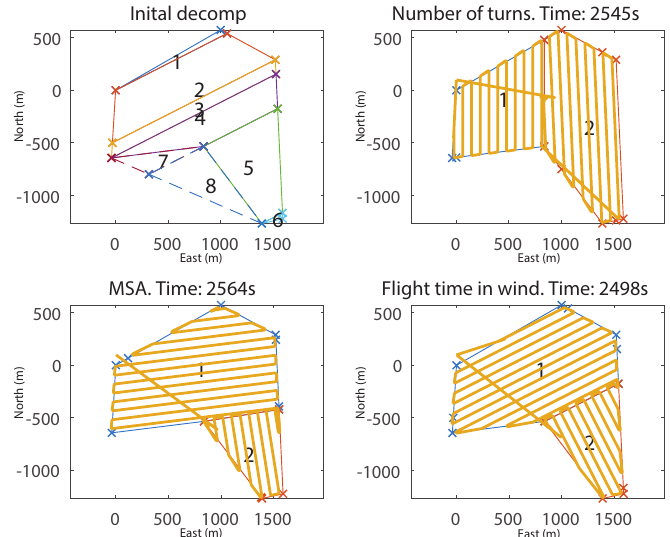
Figure 22. Final decompositions and flight paths generated from the example survey field in Figure 19 in zero wind, for FTIW, MSA and